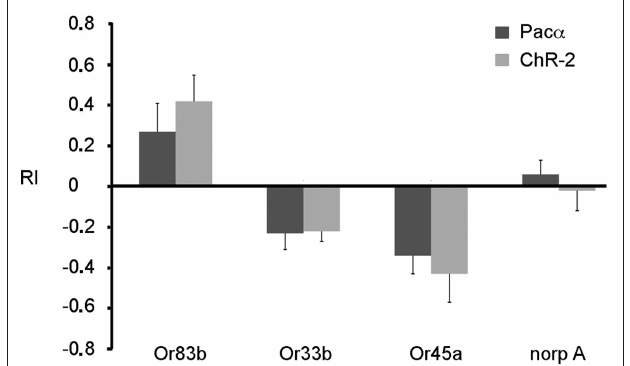
Figure 6 | expression of either Chr-2 or Pac α in the mutant norpA background. Larvae expressing ChR-2 or Pac α in all ORNs (Or83b) are attracted by the blue light. On the contrary, larvae expressing these proteins in Or33b or Or45a neurons are repelled by blue light. The UAS-ChR-2 or UAS-Pac α lines in the mutant norp A background ( norp A ) show no phototaxis. Bars represent mean ± SEM ( n = 10